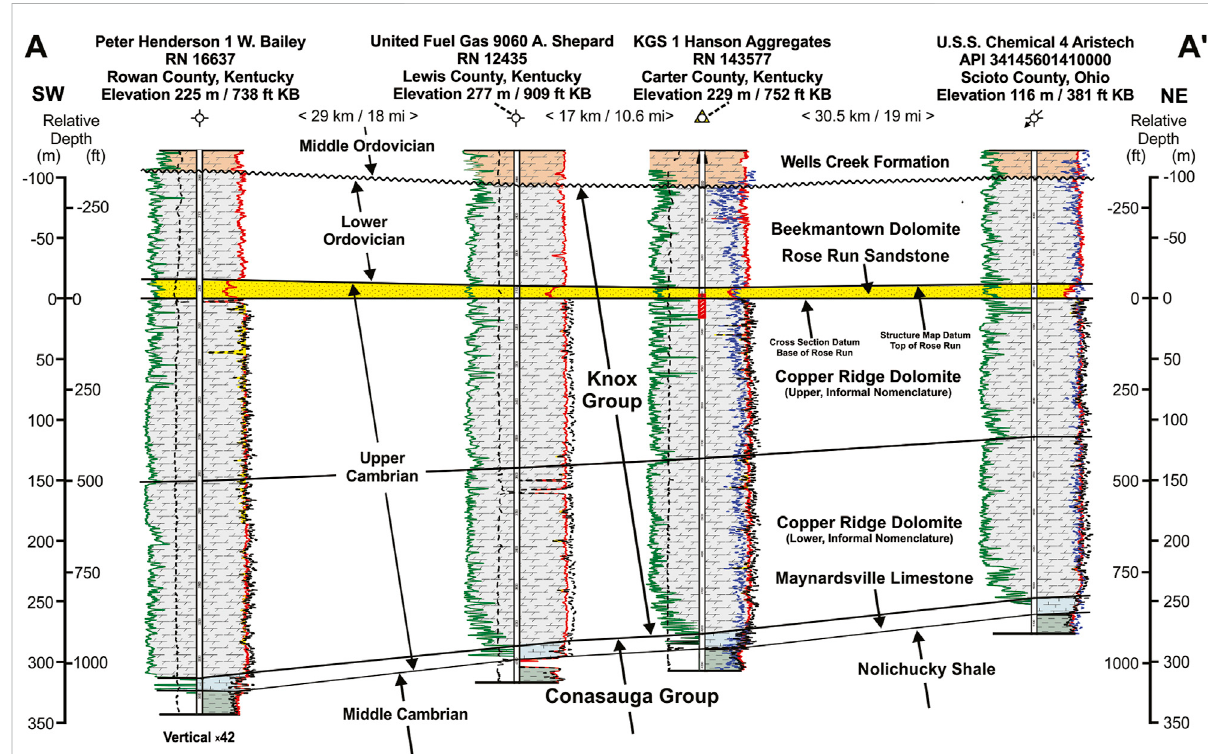
FIGURE 4 Stratigraphic cross section A – A ′ of the Knox Group oriented approximately southeast – northeast. Datum is the base of the Rose Run. The Rose RunthinsintocentralandsouthwestCarterCounty,andthenthickensintoRowanCounty(Figure5).RNistheKGSrecordnumberandAPIisthewell API